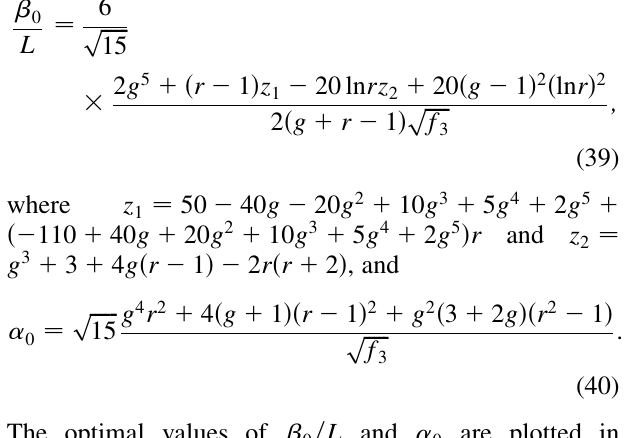
FIG. 8. The optimal bending profile parameter r as a function of (cid:12) for minimum AME emittance. The red curve is given by the approximate expression r 5 : 81 (cid:12) þ 0 : 101 (cid:12) 2 þ 0 : 003 79 (cid:12) 3 (cid:1) 0 : 000 364 (cid:12) 4